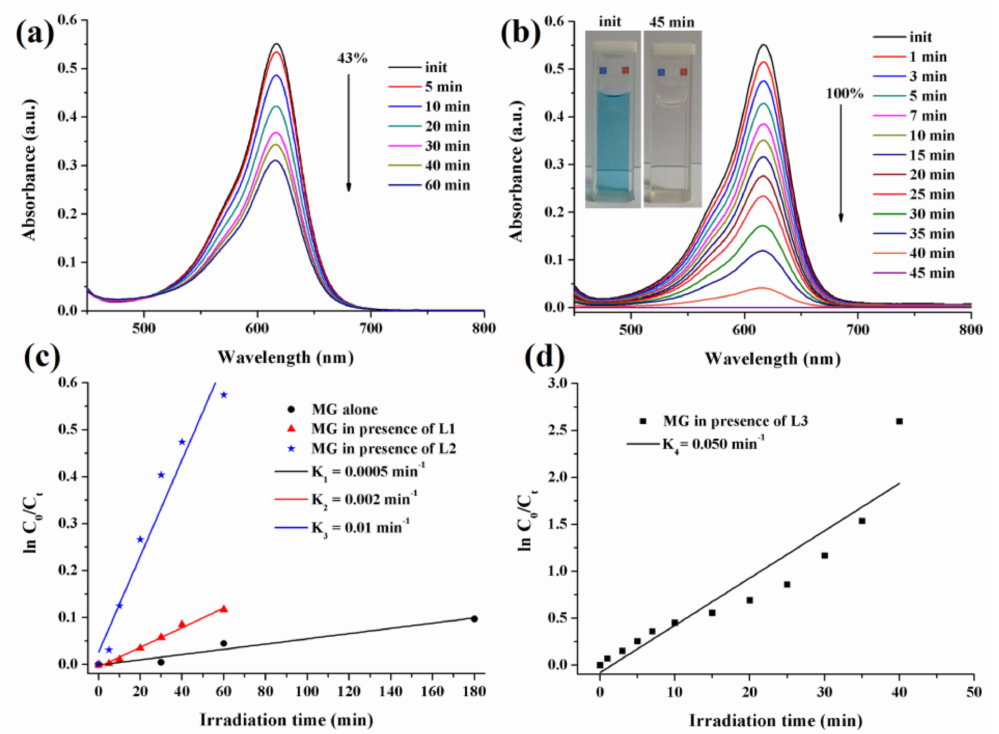
Figure 9. Irradiation-induced evolution of UV-Vis absorption spectra of malachite green (MG) solutions when L2 ( a ) and L3 ( b ) were used as photocatalysts and the corresponding kinetic curves for MG dye degradation ( c , d